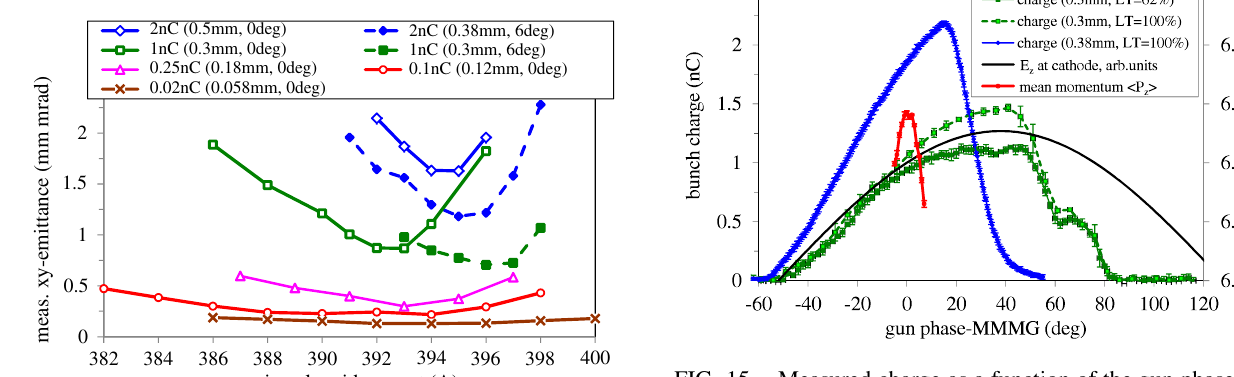
FIG. 15. Measured charge as a function of the gun phase w.r.t. the MMMG phase. Different curves correspond to various rms spot sizes of the laser at the cathode (0.3 and 0.38 mm) and different laser intensities (laser transmission—LT). The mea- sured mean momentum after the gun is plotted against the right axis. The longitudinal component of the rf electric field at the cathode is plotted against the left axis. This curve is normalized to the field at the MMMG